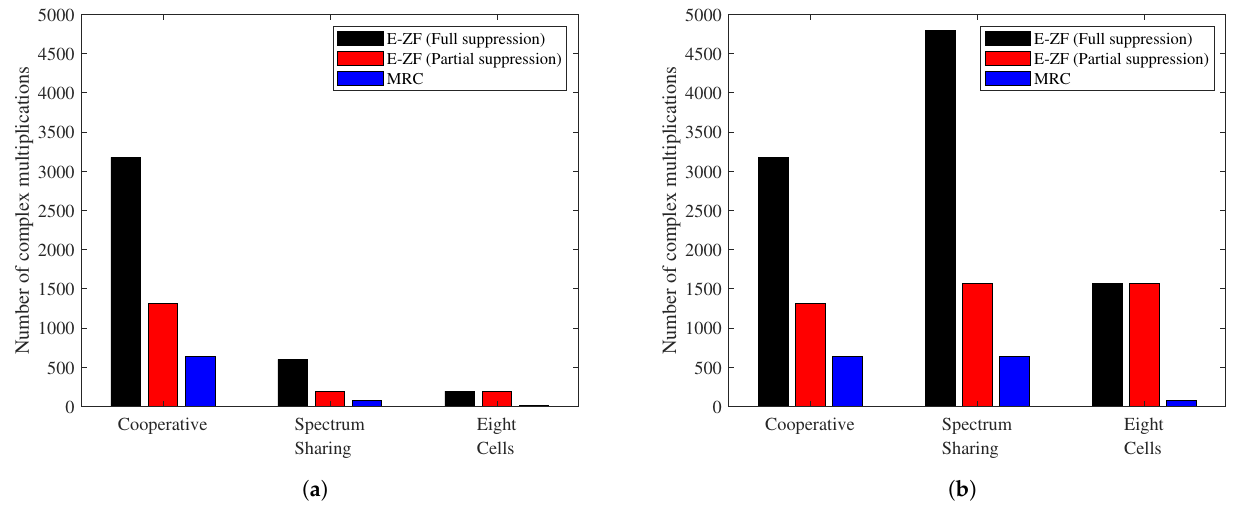
Figure 8. Computational cost required to estimate the different combining vectors in each analysed scenario. For E-ZF with partial suppression, only four users are considered. ( a ) Number of complex multiplications per CPU. ( b ) Total number of complex multiplications per